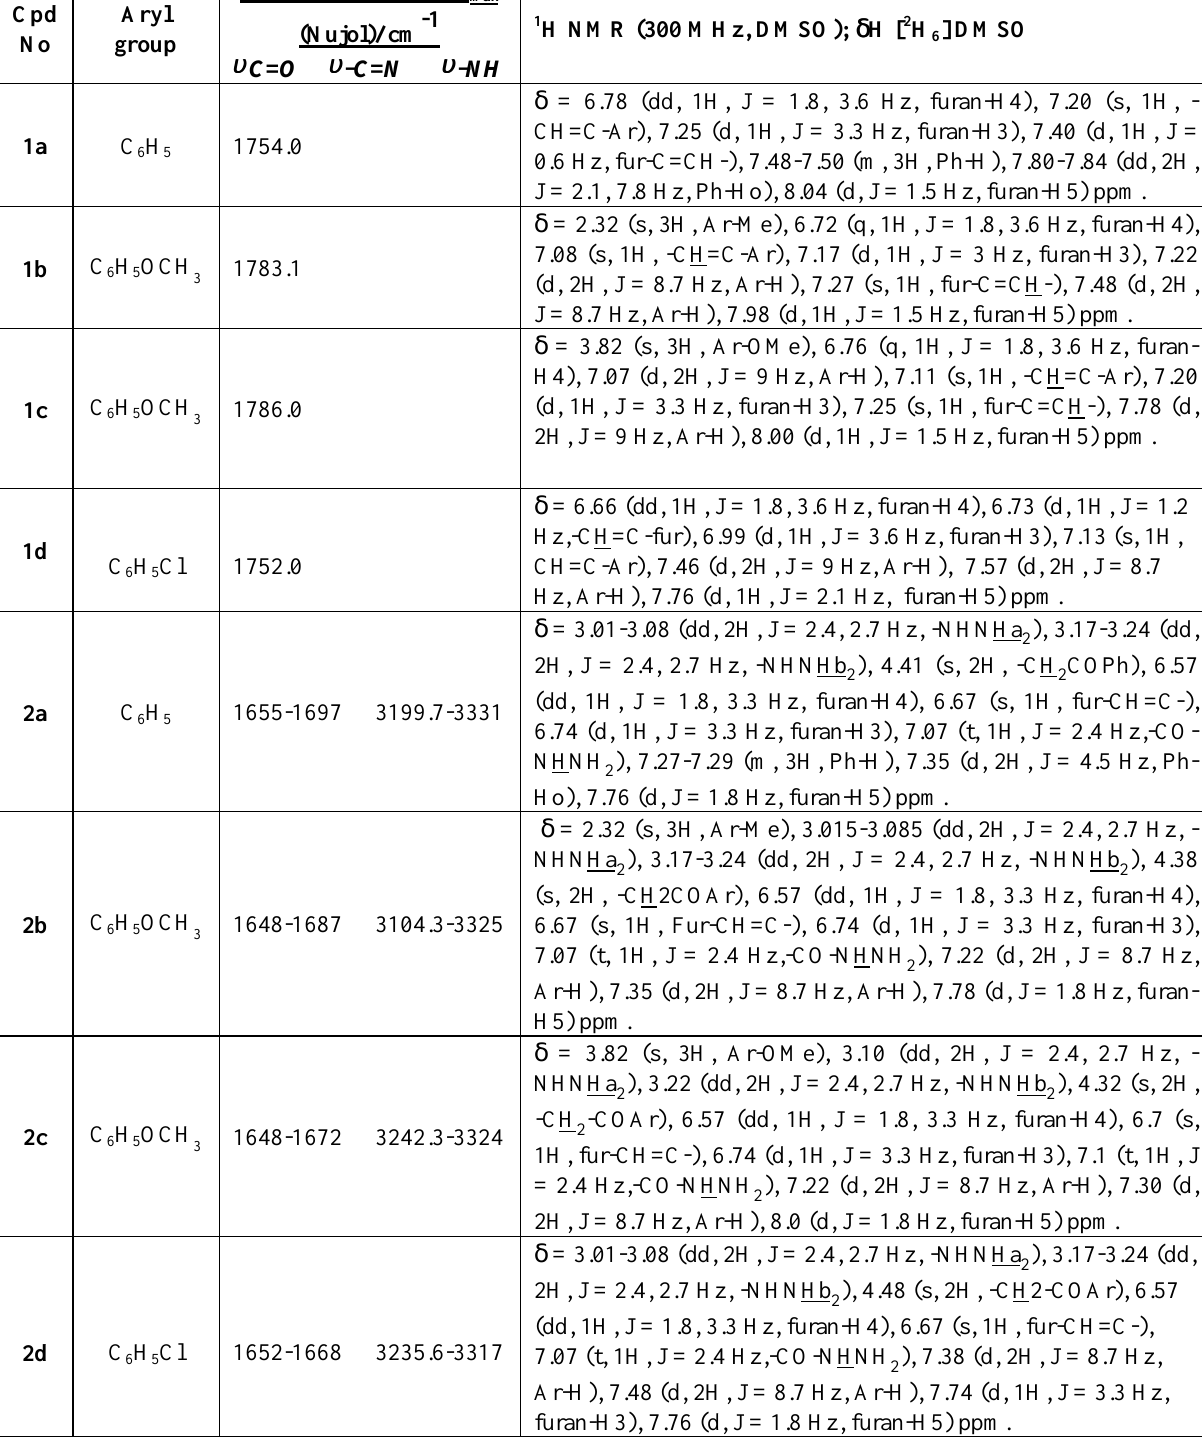
Table 1. Infrared (IR) and 1 H NMR (300 MHz) spectral data for compounds 1a - 8d . Cpd Aryl No